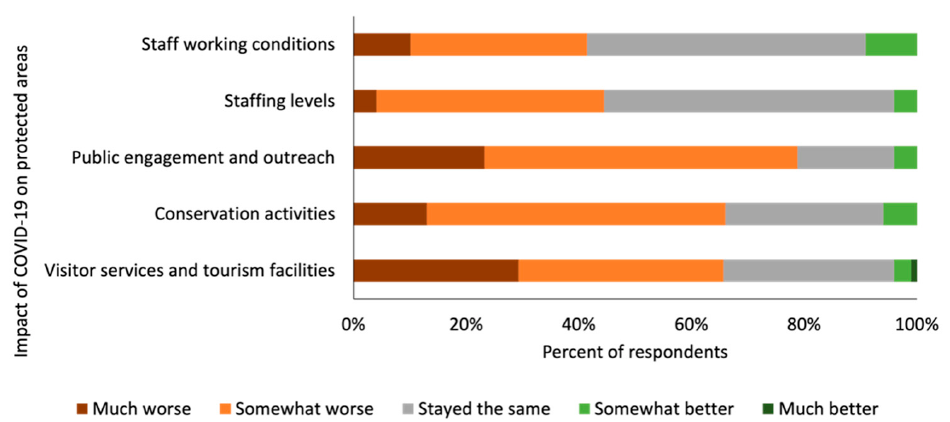
Figure 2. Opinions given by respondents on the how the COVID-19 pandemic had affected different aspects of protected area functioning and governance.